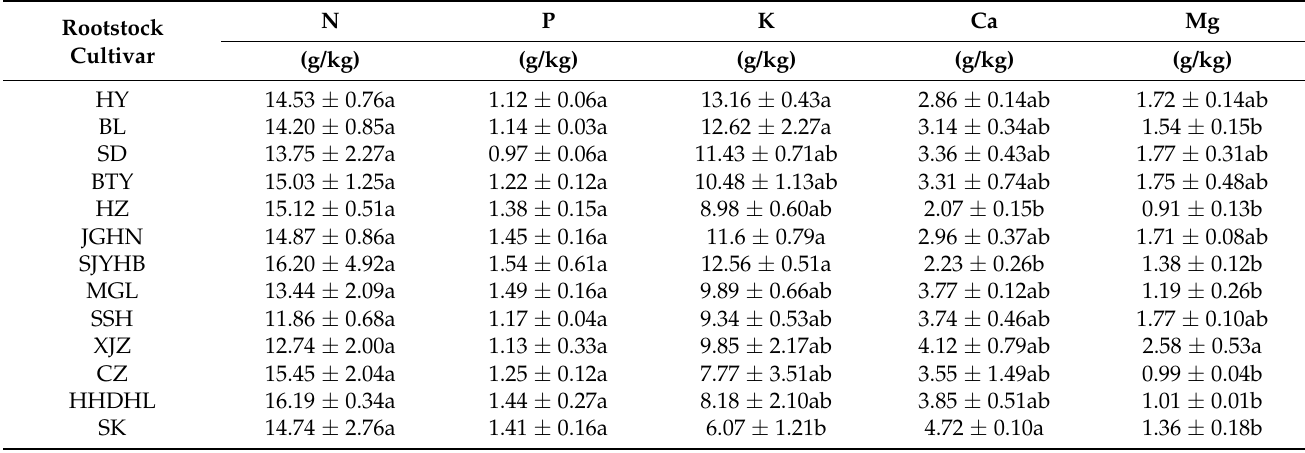
Table 4. Macronutrients in the leaves of ‘Lingfengnuo’ grafted onto different rootstocks.